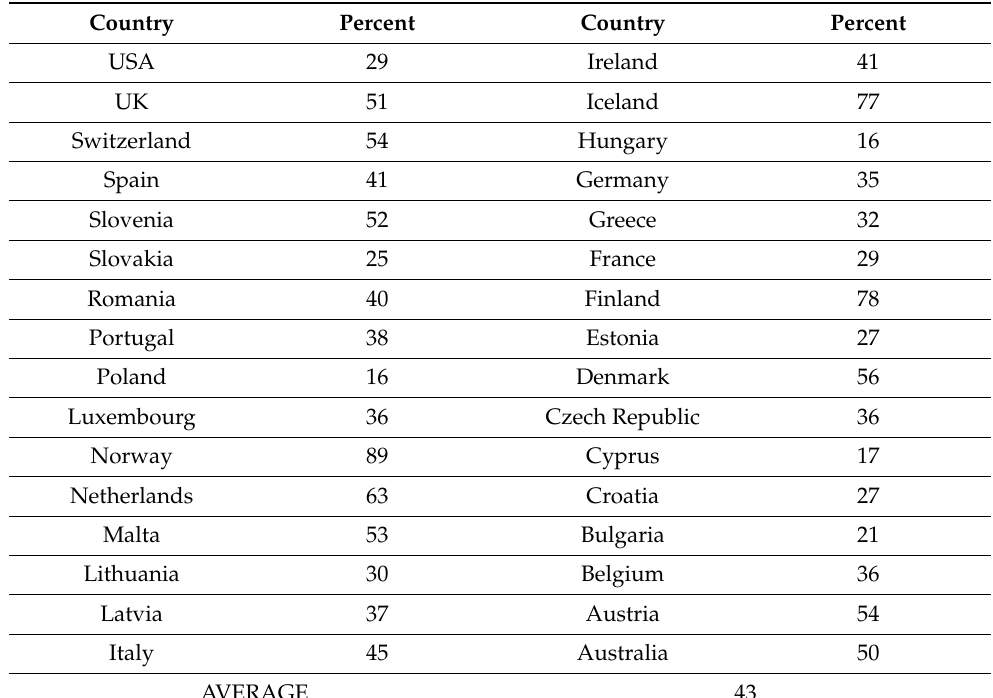
Table 3. Extra expenditures as a proportion of household consumption in high income countries.